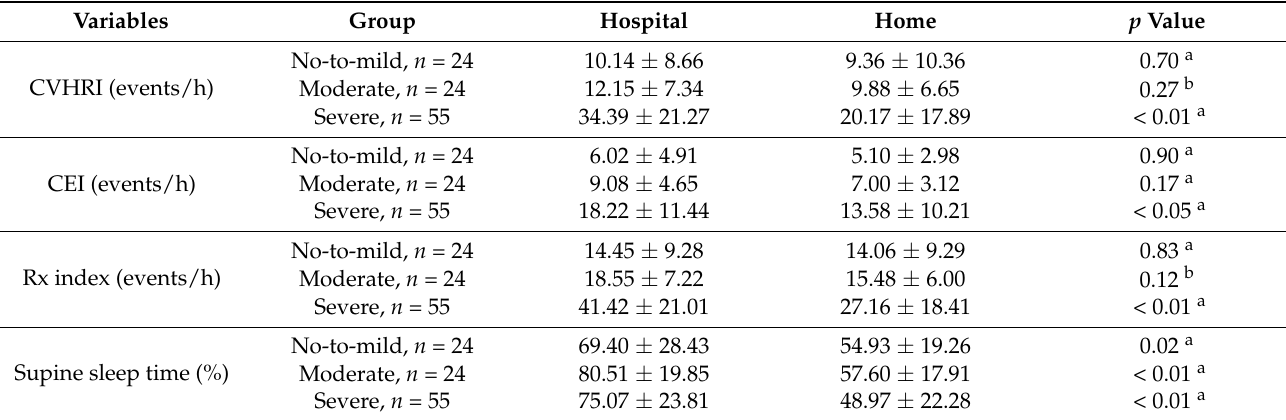
Table 3. Comparison of the home- and hospital-based RootiRx results in the high-sleep-quality groups (sleep efficiency ≥ 80%).